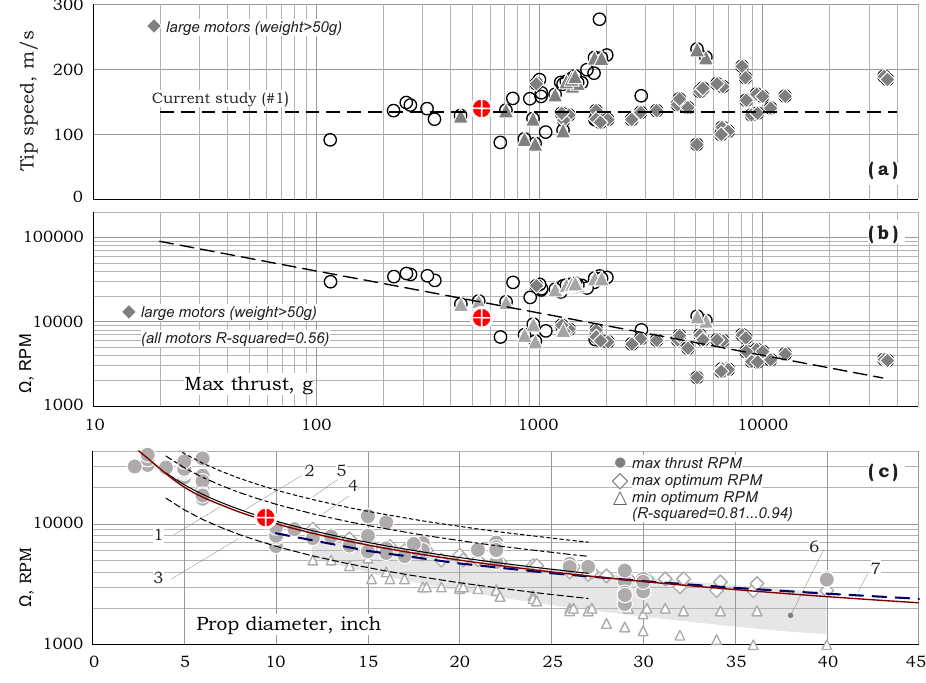
Figure 2. Propellers tip velocity and rotational velocity design trends, [15–18]. As shown, for most propellers, tip velocity varies in the range of 100–200 m/s with low dependency on thrust level. However, Figure 2b shows that the rotational velocity, Ω , decreases with increasing thrust levels as